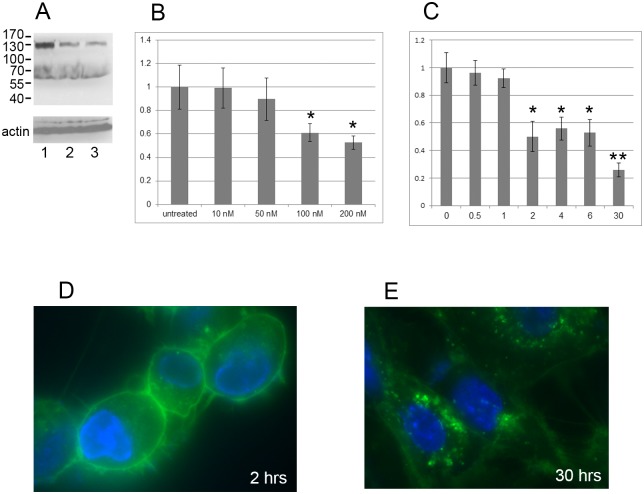
Ouabain causes dephosphorylation of a 130 kDa protein.(A) Cells were treated with ouabain for 24 hrs, collected and analysed by western blotting using 4G10 monoclonal antibody (upper panel) and anti-actin antibody as a loading control (lower panel). Lane 1, untreated control; lane 2, ouabain at 100 nM; lane 3, ouabain at 500 nM. (B) Ouabain dose response curve. Cells were treated with indicated concentrations of ouabain and analyzed by western blotting using 4G10 monoclonal antibody and anti-actin antibody. Quantitation of the amount of tyrosine phosphorylated 130 kDa protein was done using NIH Image J. The diagram shows the change of the treated sample with respect to untreated control (set at 1). The difference between untreated and 100 and 200 nM is statistically significant (P<0.05) (indicated by *). (C) Ouabain time course analysis. Cells were treated with 100 nM ouabain for indicated times (hrs) and analyzed as above. Quantitation of the amount of tyrosine phosphorylated 130 kDa protein was done using NIH Image J. The diagram shows the change after treatments with the zero-time point arbitrarily set at 1. The difference between 0 hrs and 2–6 hrs is statistically significant (P<0.05; indicated by *) and the difference between 30 hrs and earlier time points is also statistically significant (P<0.05; indicated by **). (D) and (E) Fluorescent-labeled ouabain was incubated with RPE cells and images were taken at 2 hrs (D) and 30 hrs (E). Green represents fluorescent-labeled ouabain and blue represents DAPI-stained DNA.